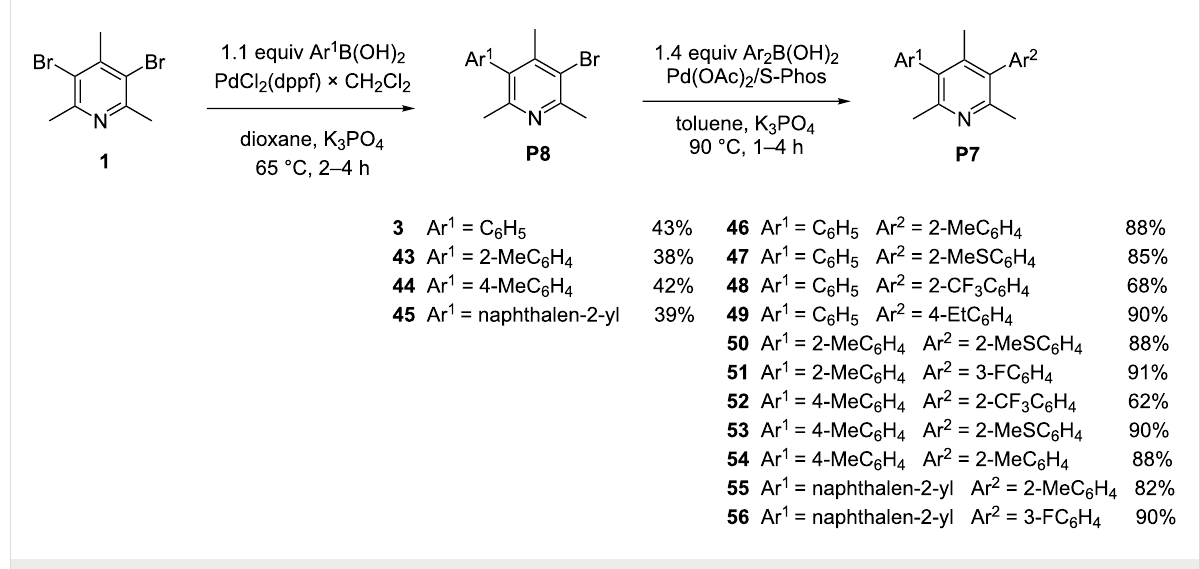
Scheme 3: Preparation of unsymmetrical 3,5-diaryl-2,4,6-trimethylpyridines 46–56